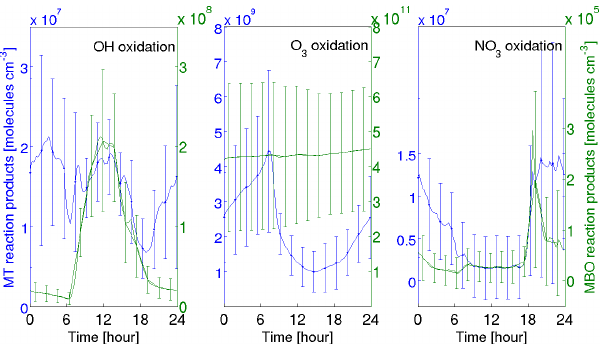
Figure 9. Averaged 1-day number size distributions based on the DMPS measurements and model experiments I–III. The concen- tration unit: moleculescm − 3 . DMPS instrument has cutoff size at 15nm. The averages are made only for periods when measurements are available. Table 1. Saturation vapor concentration of each organic condensing vapor; unit: # cm − 3